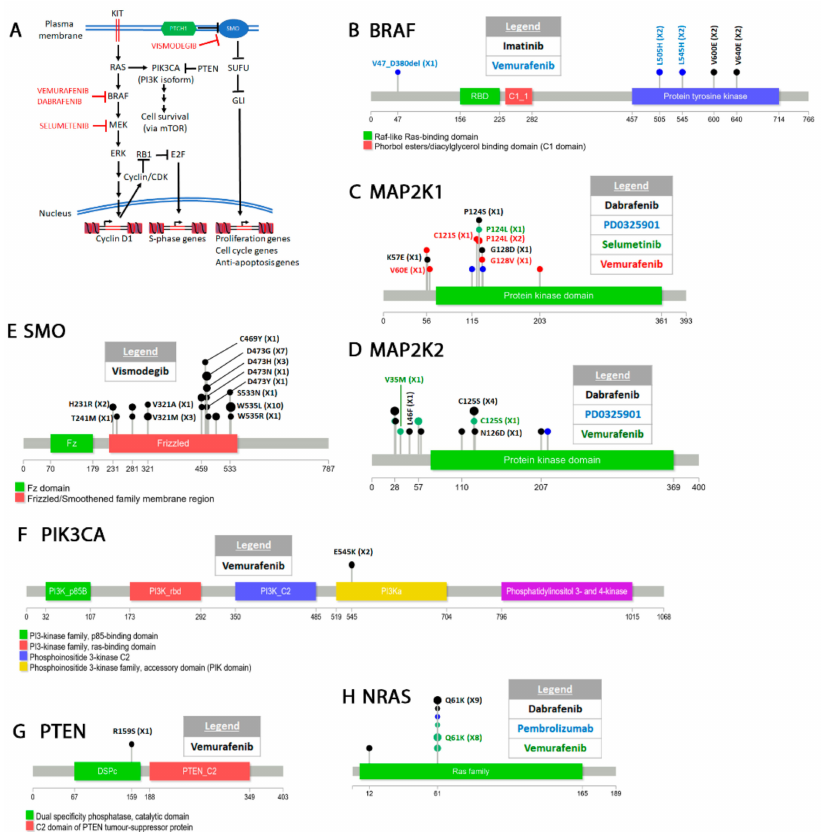
Figure 4. Drugs that target melanoma pathways. ( A ) Some of the signal transduction pathways discussed here and the drugs that target them. Please see text for details. ( B ) Drug resistant point mutations arising in BRAF. Also shown is one structural alteration. Other resistant structural alterations of BRAF are listed in Supplementary Table S4. ( C–F ) Secondary mutations acquired in the other genes involved in the pathways shown in ( A